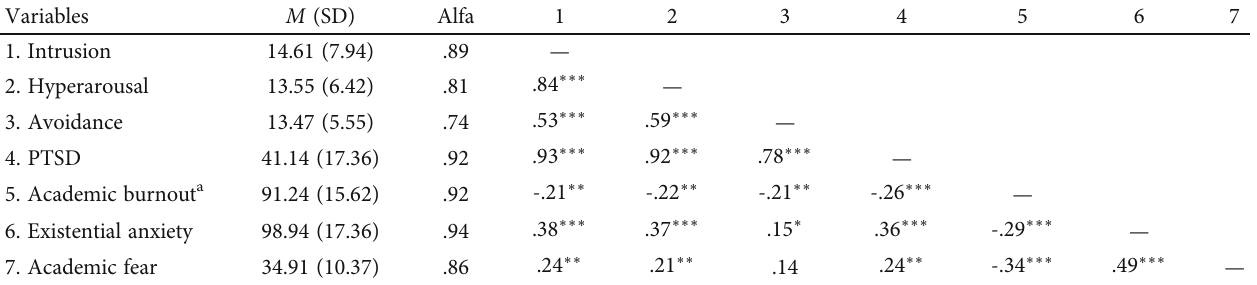
Table 3: Descriptive statistics, reliability, and Pearson ’ s correlation coe ffi cients ( N = 199 ).